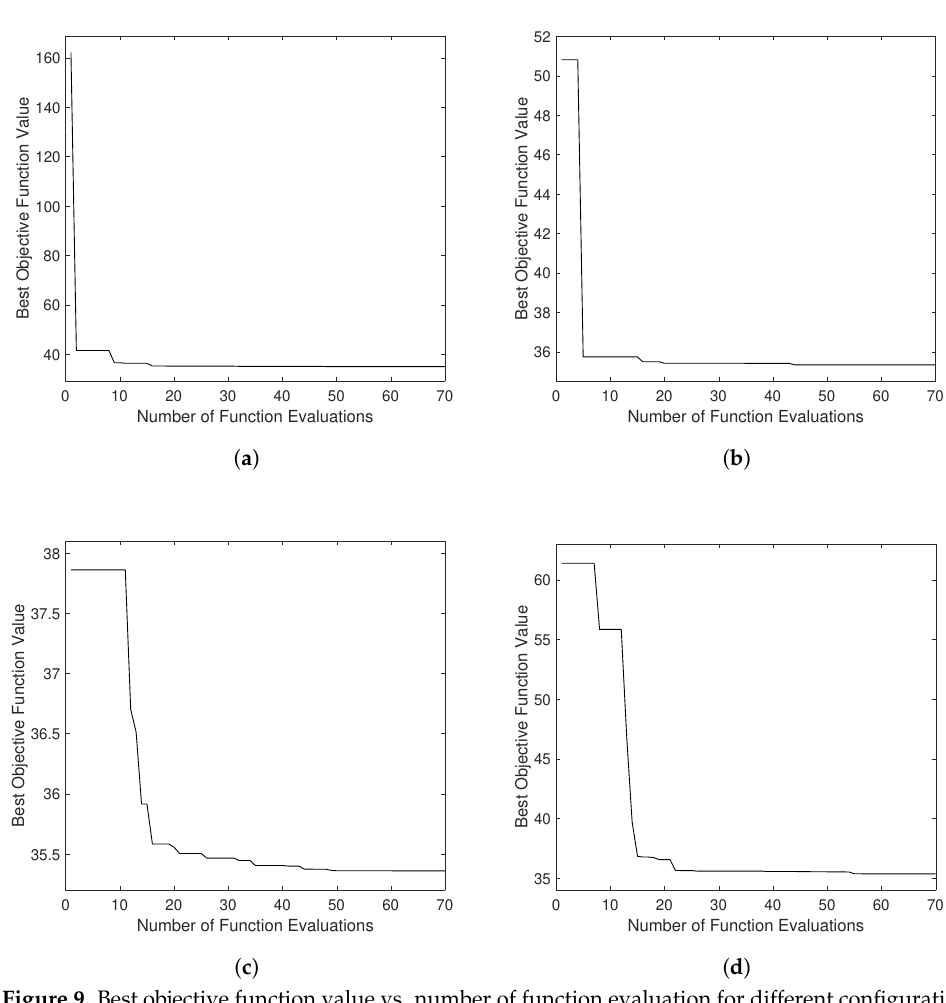
Figure 9. Best objective function value vs. number of function evaluation for different configurations: ( a ) Configuration DM1S1C. ( b ) Configuration H3M1C. ( c ) Configuration H5M1C. ( d ) Configuration H5M3C. The objective function is the inverse of the output